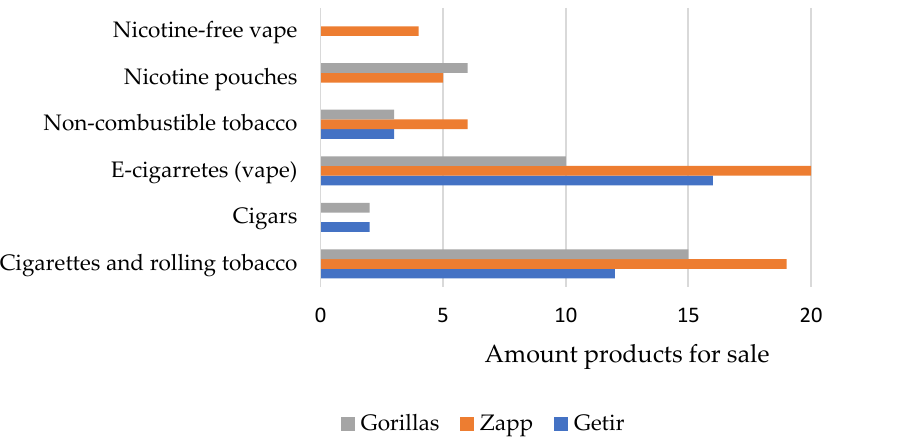
Figure 2. Tobacco and e-cigarette sold by dark grocers [November